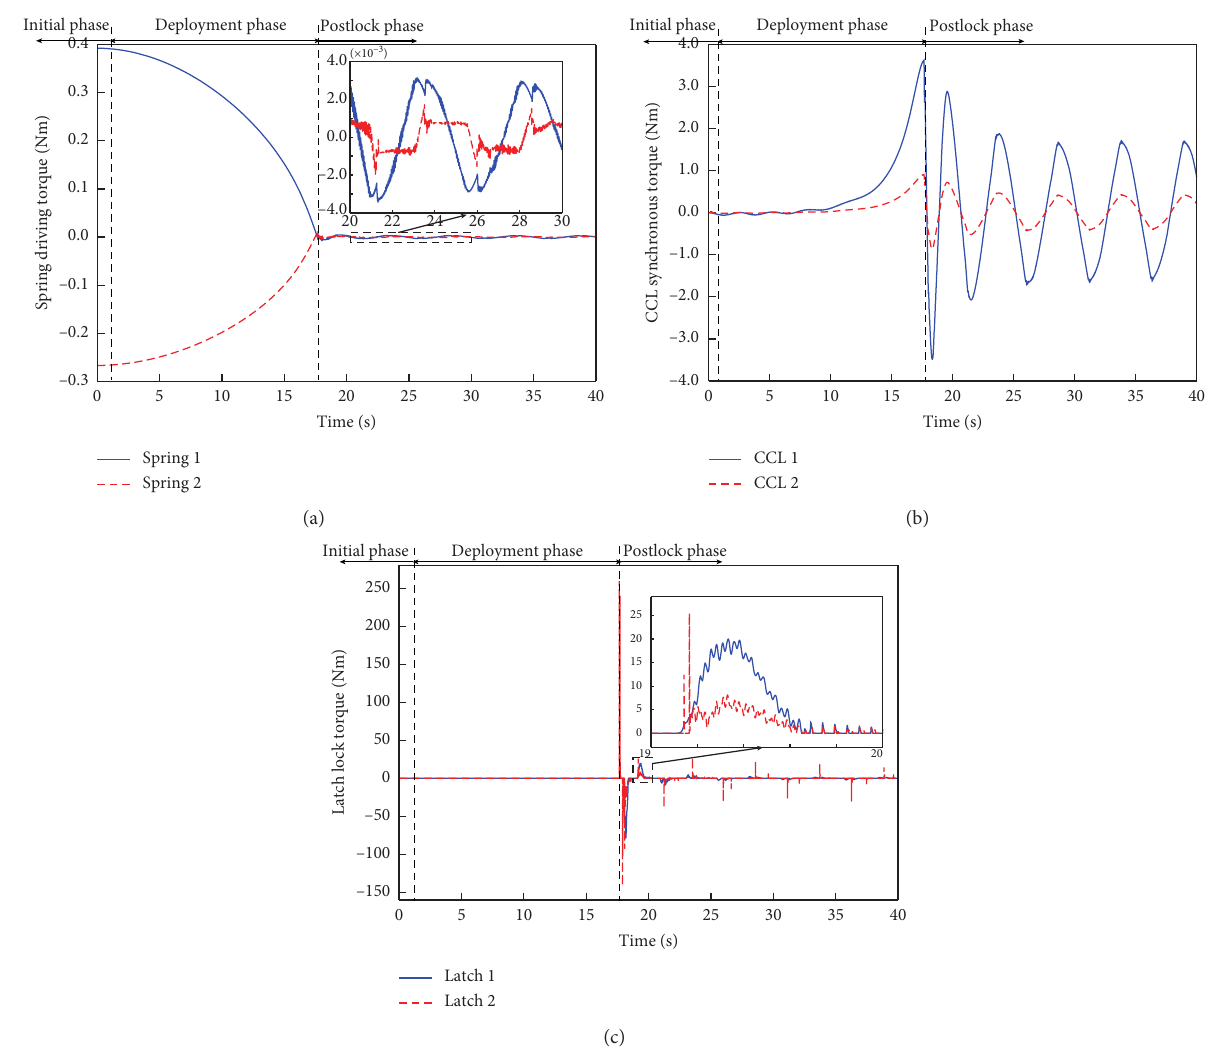
Figure 12: Torque responses of the solar array